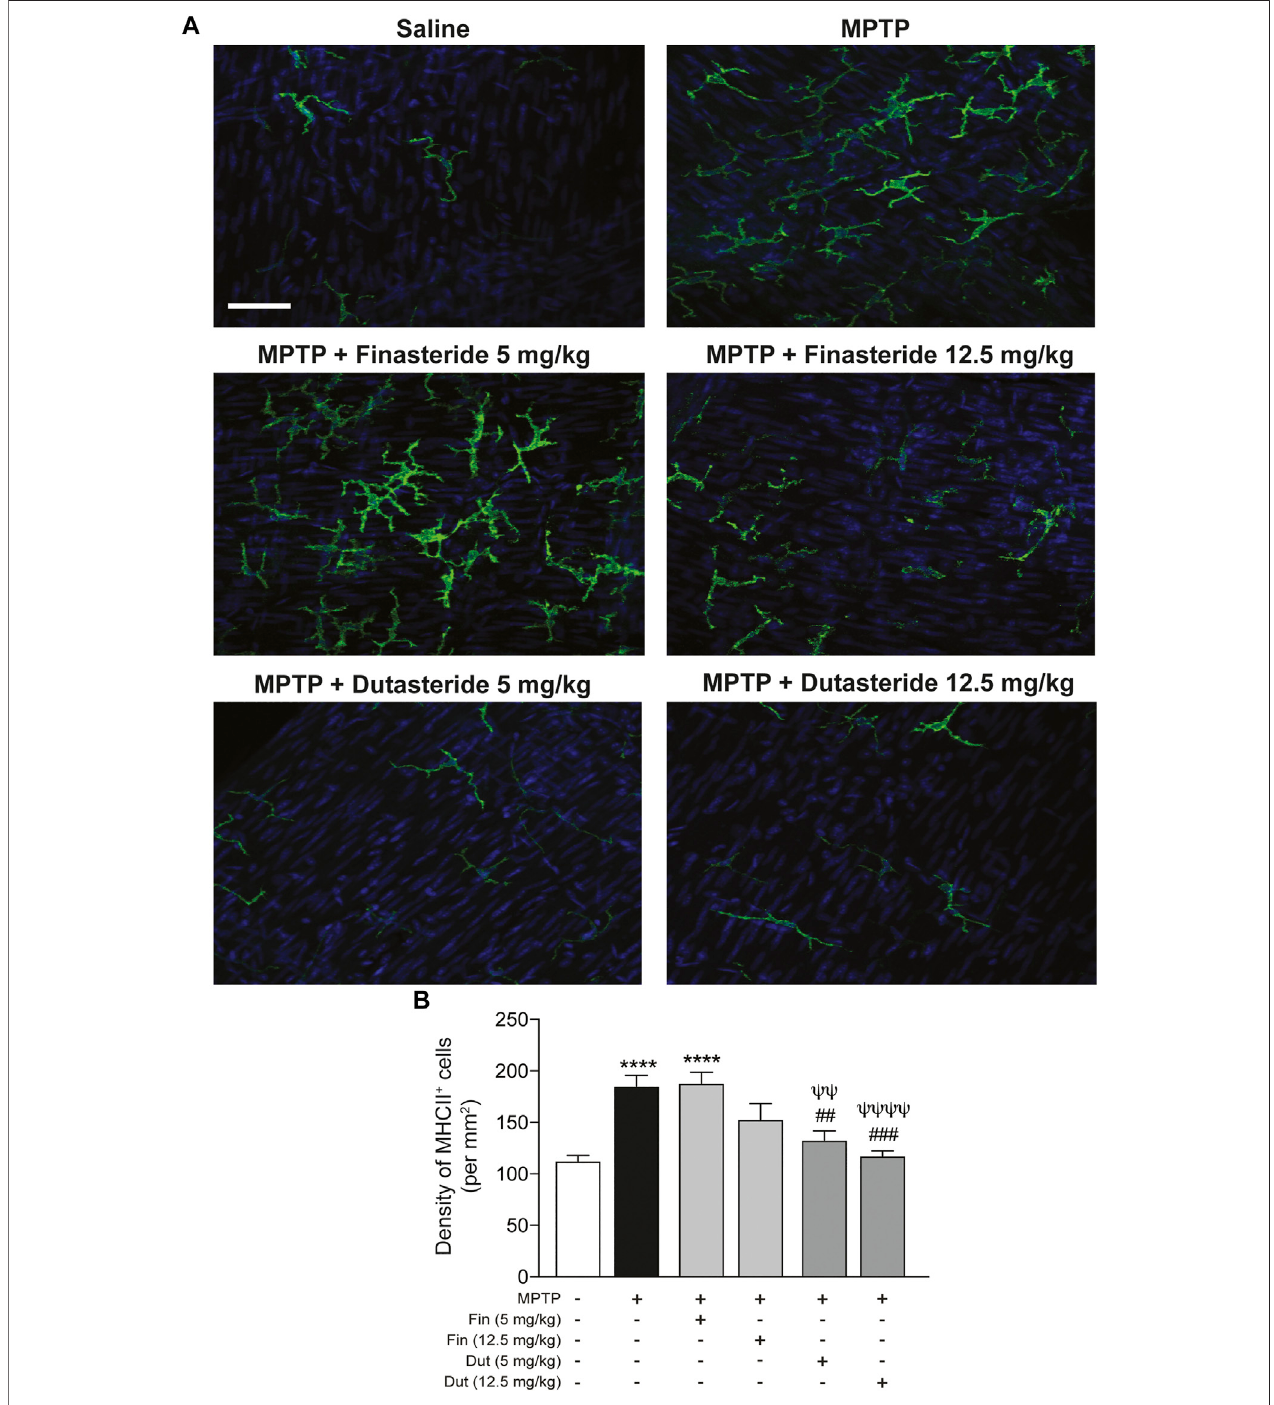
FIGURE4| Proin fl ammatorymacrophagesdensityincreasedbyMPTPwasreducedbydutasteridetreatmentinthemyentericplexus,whereas fi nasteridegavean inconclusive effect. (A) Photomicrographs ofMHCIIimmuno fl uorescence labeling in the myenteric plexusof thedistalileum; scale bar = 25 µm. (B) Stereological counts of MHCII + cells showed that dutasteride (Dut) (5 and 12.5 mg/kg) prevented the increase of proin fl ammatory macrophages in the myenteric plexus of MPTP mice, whereas fi nasteride treatment at 5 mg/kg was ineffective and at 12.5 mg/kg led to no change compared to controls or vehicle-treated MPTP mice. Values shown are the average densities (per mm 2 ) ± SEM of 10 mice per group. **** p < 0.0001 compared to saline control mice; ## p < 0.01 and ### p < 0.001 compared to MPTP lesioned mice; ψψ p < 0.01 and ψψψψ p < 0.0001 compared to MPTP + fi nasteride (5 mg/kg) treated mice.